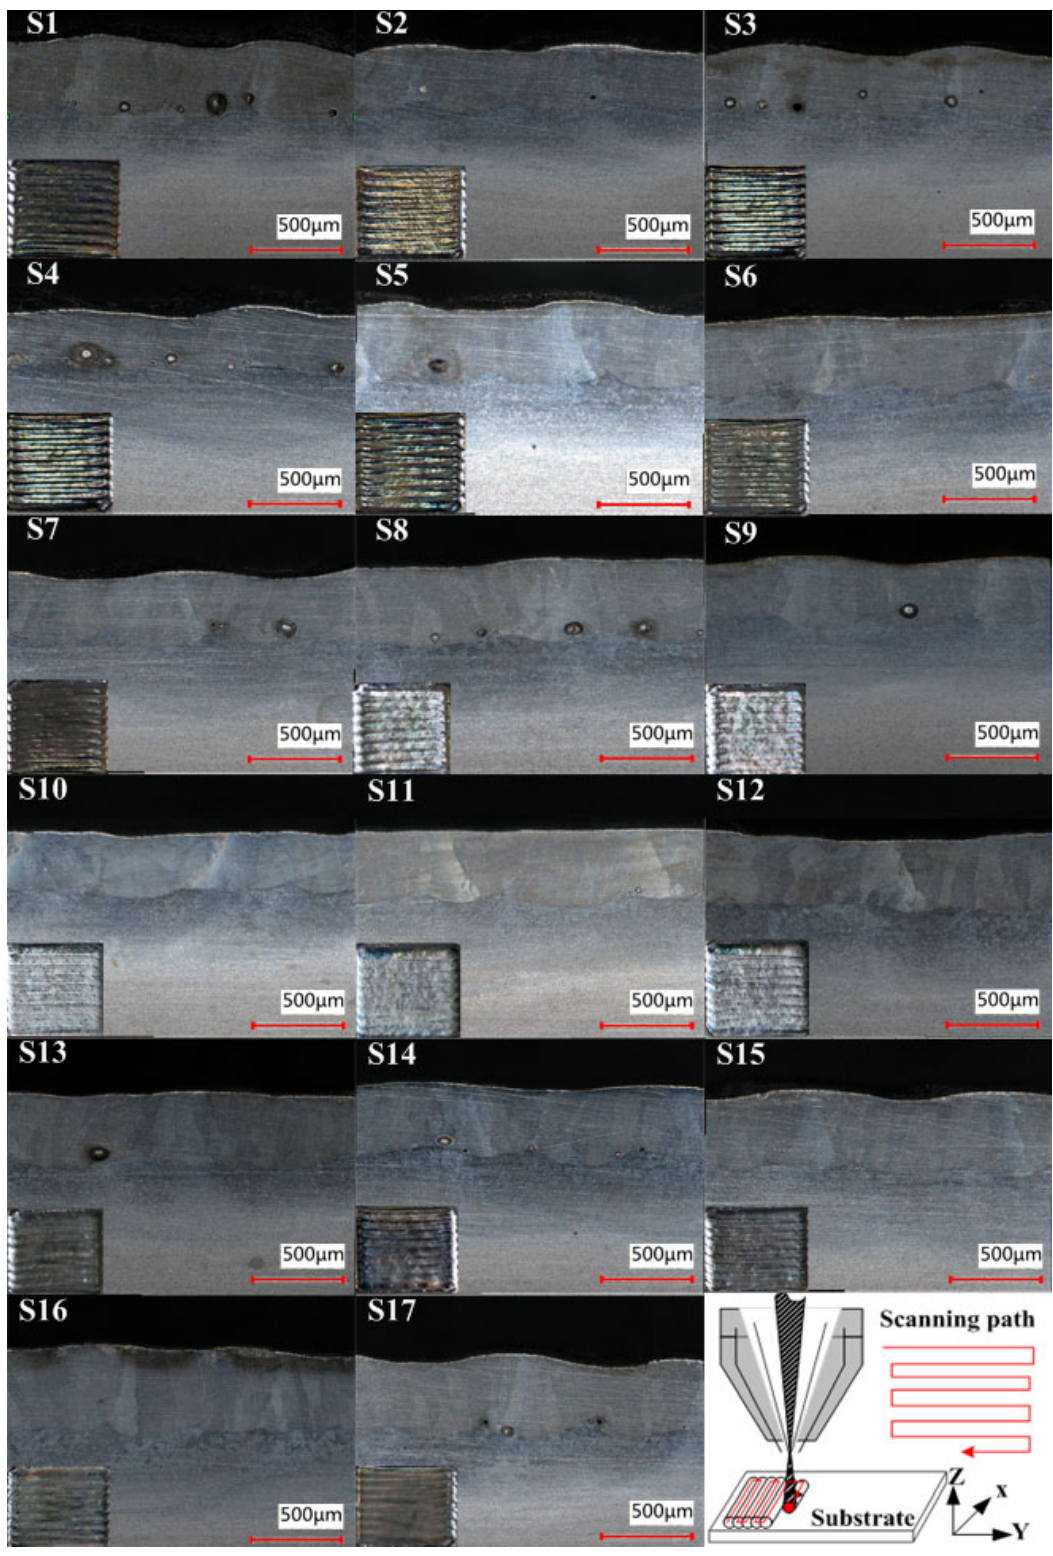
Figure 3. Surface of each specimen after cladding. Microhardness was measured by HV ‐ 1000 Vickers hardness. The average friction co ‐ efficient was measured by the MMW ‐ 2 friction tester. The input variables of the BBD ex ‐ perimental design and their corresponding response values are shown in Table 2.